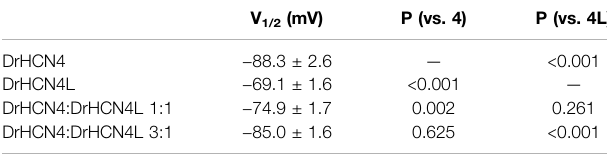
TABLE 3 | V 1/2 (mV) and p -values for the homomeric and heteromeric channels.